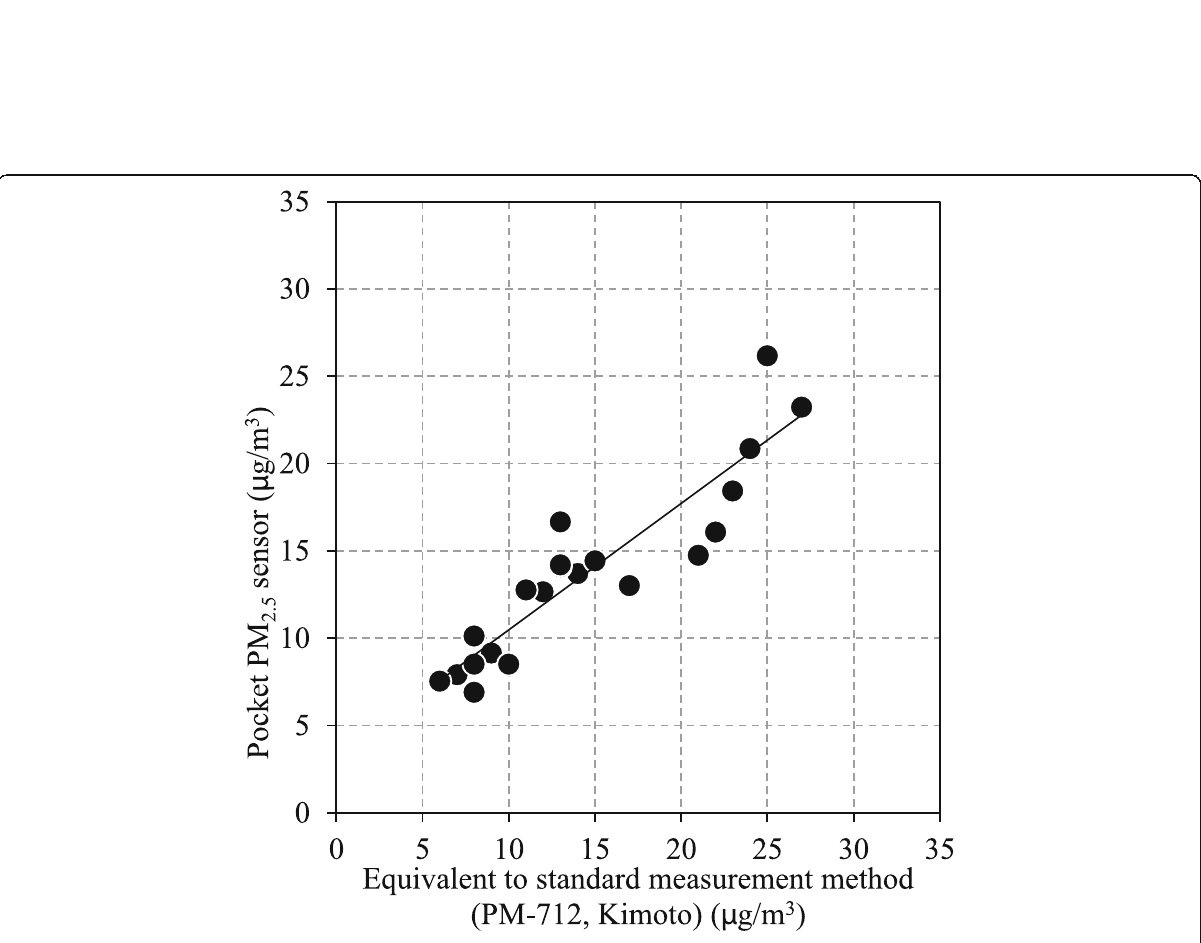
Fig. 3 Validity assessment of Pocket PM 2.5 Sensor: correlation between PM-712, Kimoto and Pocket PM 2.5 Sensor. To prove validity of Pocket PM 2.5 Sensor for measuring PM 2.5 concentration, we compared the data from PM-712, Kimoto, a fixed real-time monitor which was set up in Air Quality Research Station, NIES, Tsukuba, Japan (http://www.nies.go.jp/aqrs/index.html) and Pocket PM 2.5 Sensor simultaneously. PM-712, Kimoto recorded one hourly while Pocket PM 2.5 Sensor recorded every second, and we calculated average hour